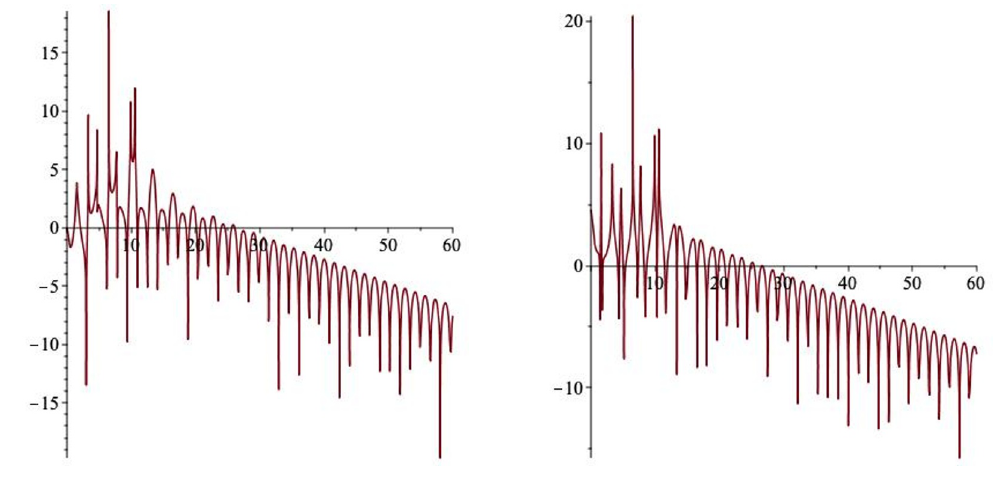
Figure 15. Plots of ln with initial condition ˙ x (0) / ˙ y (0) = 0 . 3 ; these quantities are required to be small for ingoing geodesics to approach the cap exponentially in the affine parameter. Here we have chosen µ